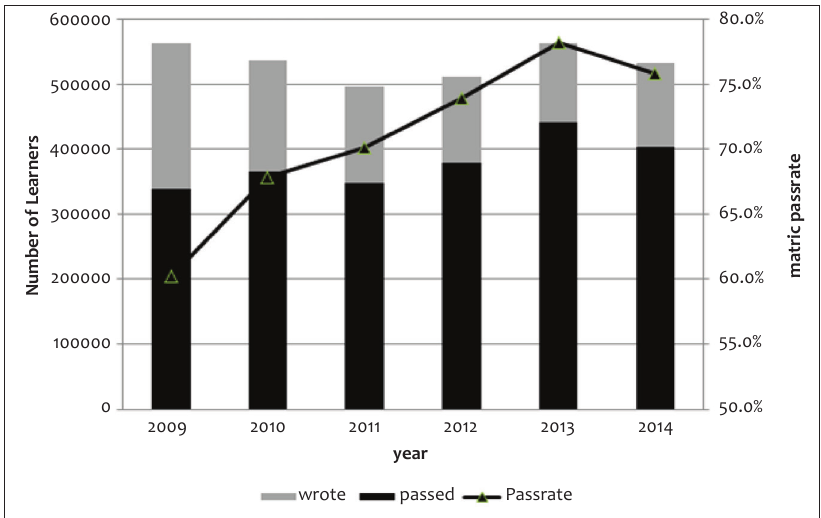
Figure 4: NSC results (2009-2013) in all schools (Source: Author’s calculations from matriculation